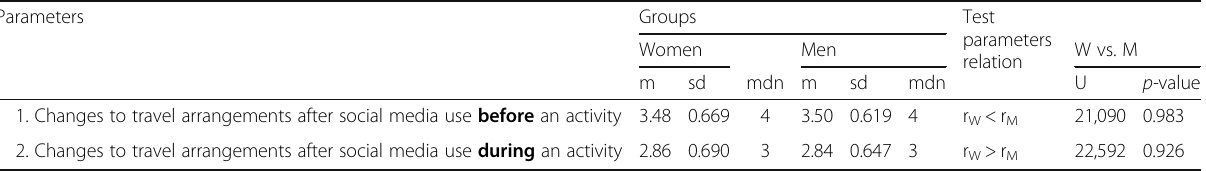
Table 8 Summary of test results for comparisons between social media use before and during an activity Parameters